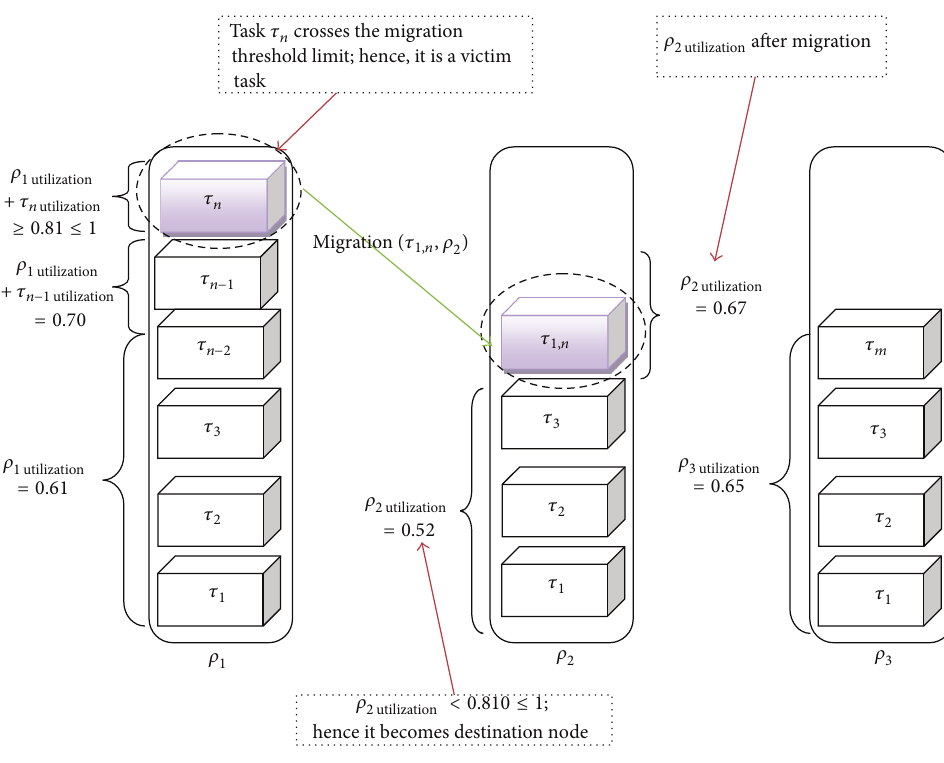
Figure 9: Migration scenario in proposed algorithm.